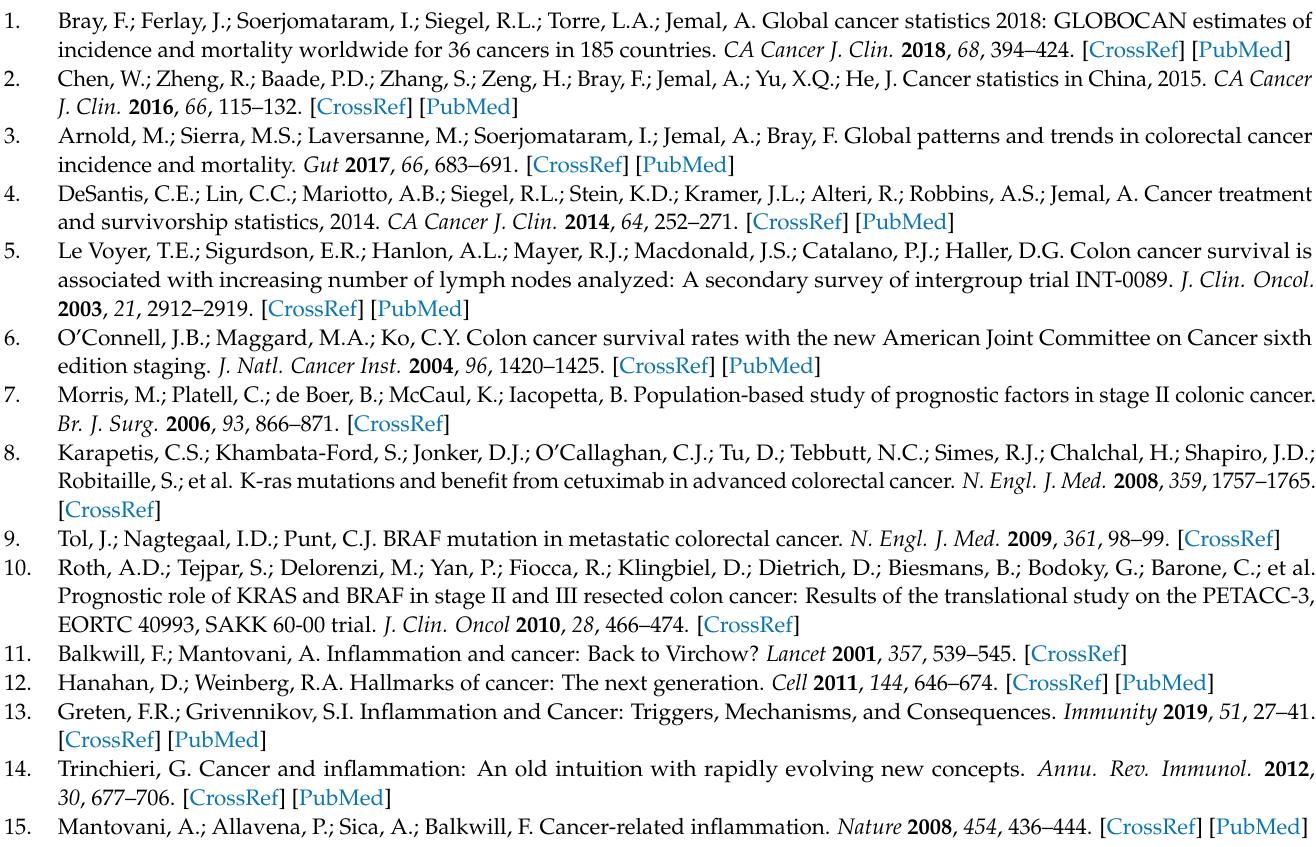
Table S6: The overall survival rates at 1-, 3-, 5-year in groups stratified by OS-PII in the validation cohort, Table S7: The disease-free survival rates at 1-, 3-, 5-year in groups stratified by DFS-PII in the validation cohort, Table S8: Time-dependent ROC analyses for predicting overall survival of patients with colorectal cancer in the training cohort, Table S9: Time-dependent ROC analyses for predicting disease-free survival of patients with colorectal cancer in the training cohort, Table S10: Time-dependent ROC analyses for predicting overall survival of patients with colorectal cancer in the validation cohort, Table S11: Time-dependent ROC analyses for predicting disease-free survival of patients with colorectal cancer in the validation cohort, Table S12: The C-index of AJCC system and nomograms, Table S13: Time-dependent ROC analyses stratified by TNM staging for predicting survival of patients with colorectal cancer in the training cohort, Table S14: Time-dependent ROC analyses stratified by TNM staging for predicting survival of patients with colorectal cancer in the validation